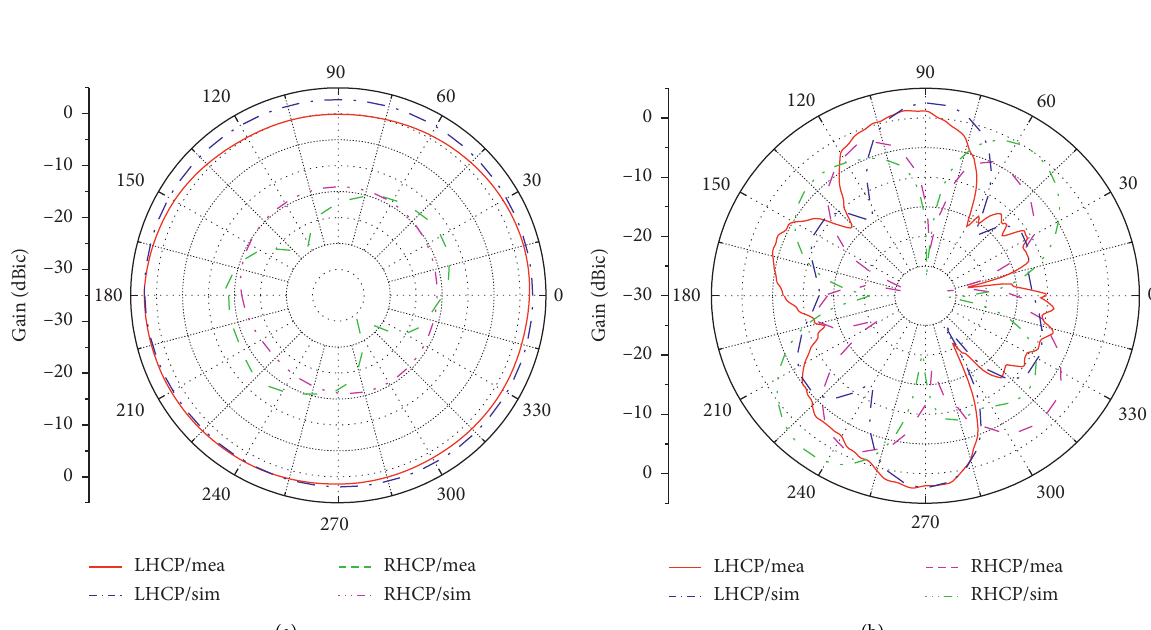
Figure 7: Reflection coefficient and axial